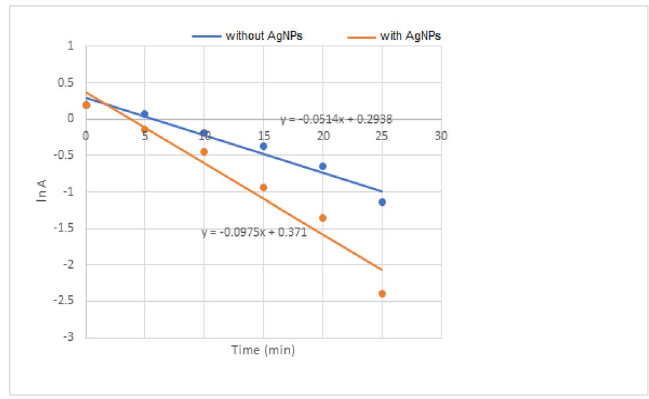
Figure 11. Dye degradation with and without silver nanoparticles.